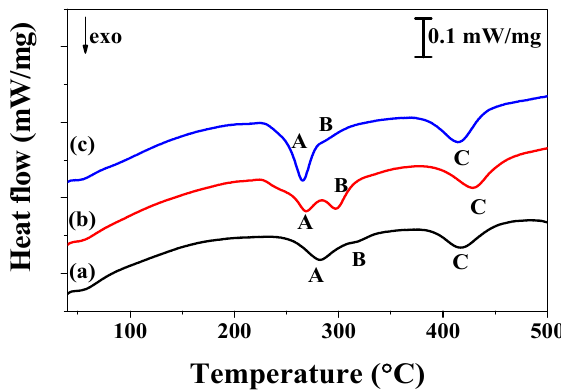
Figure 3. The heat flow curves of solid solution-treated samples according to temperature increases after quenching: ( a ) Al-1.1Mg2Si, ( b ) Al-1.9Mg2Si, and ( c ) Al-3.5Mg2Si.